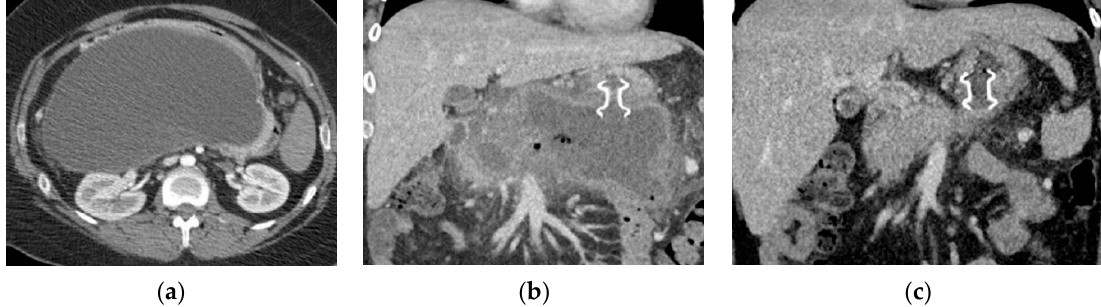
Figure 2. Computed tomography (CT) imaging of pancreatic pseudocyst. ( a ) Sagittal CT pancreas protocol image of a large 14.7 cm × 19.3 cm pseudocyst prior to lumen-apposing metal stent (LAMS) placement; ( b ) coronal CT image of pancreatic pseudocyst one day post-LAMS placement; and ( c ) coronal CT image of pancreatic pseudocyst six weeks post-LAMS placement.